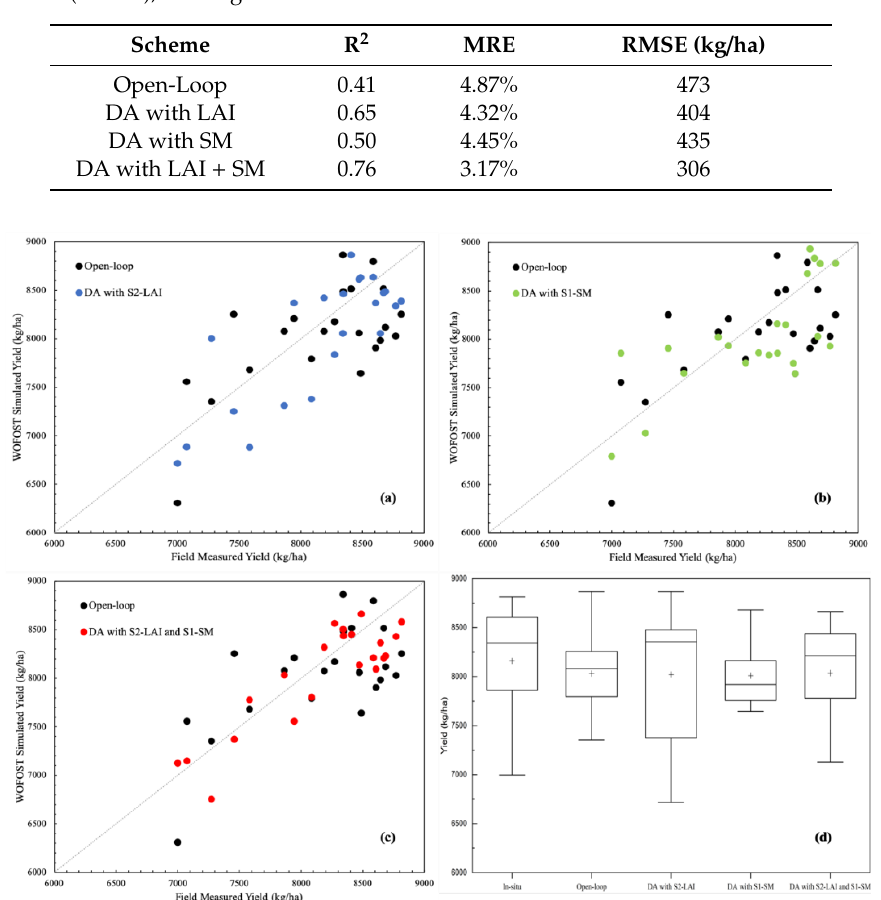
Figure 6. Comparisons of winter wheat yield estimated by the WOFOST model with open-loop and different DA strategies over the field scale in Hengshui in 2017.